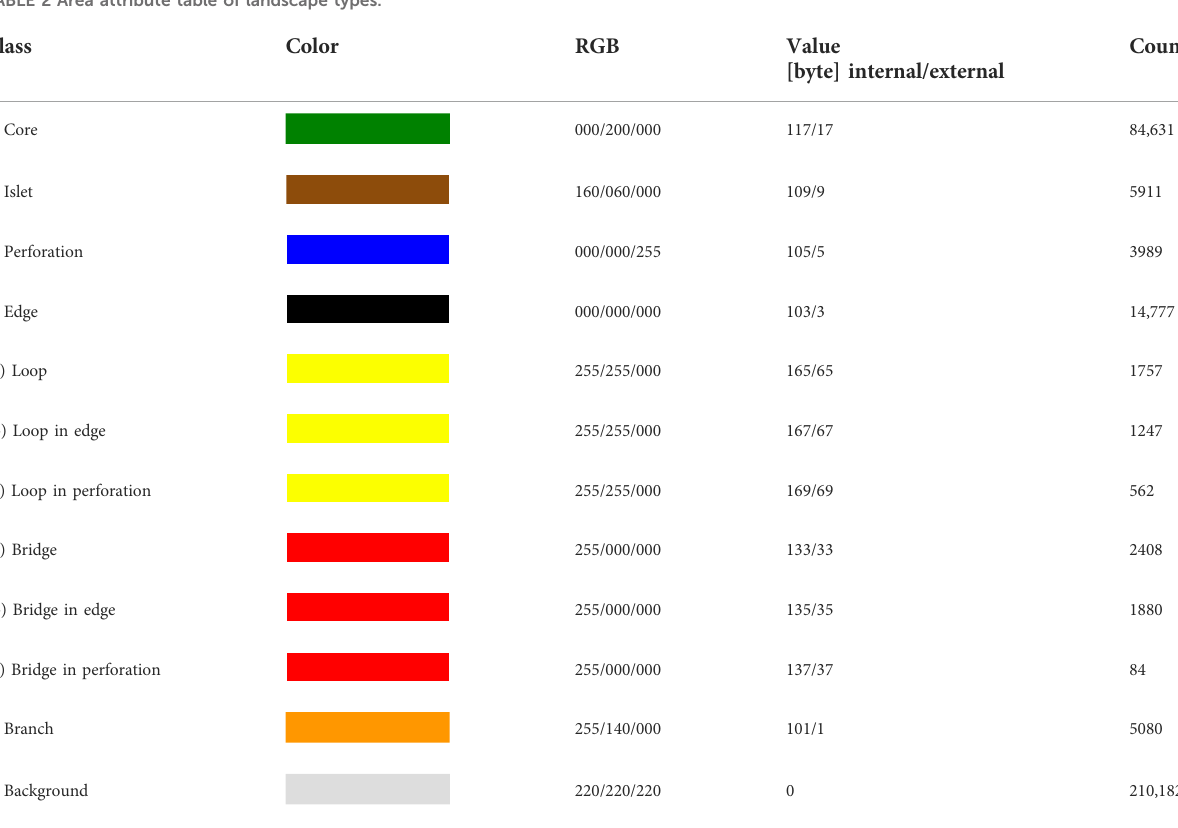
TABLE 2 Area attribute table of landscape types.